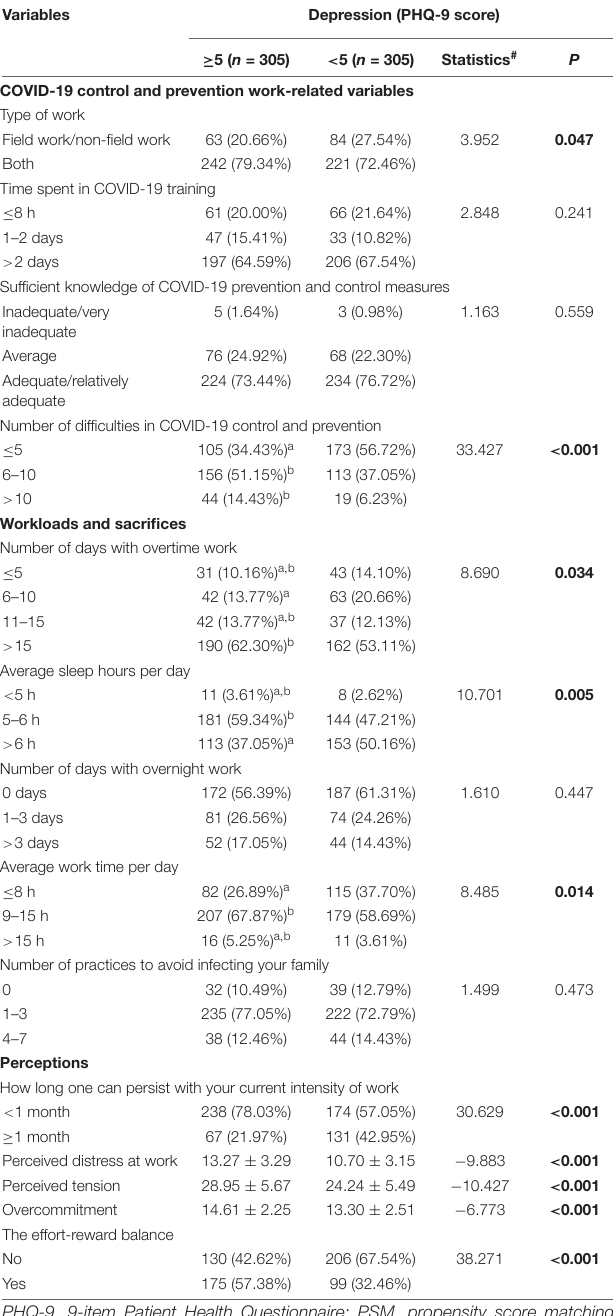
TABLE 4 | Univariate analysis results of variables related to depression after PSM ( n ,